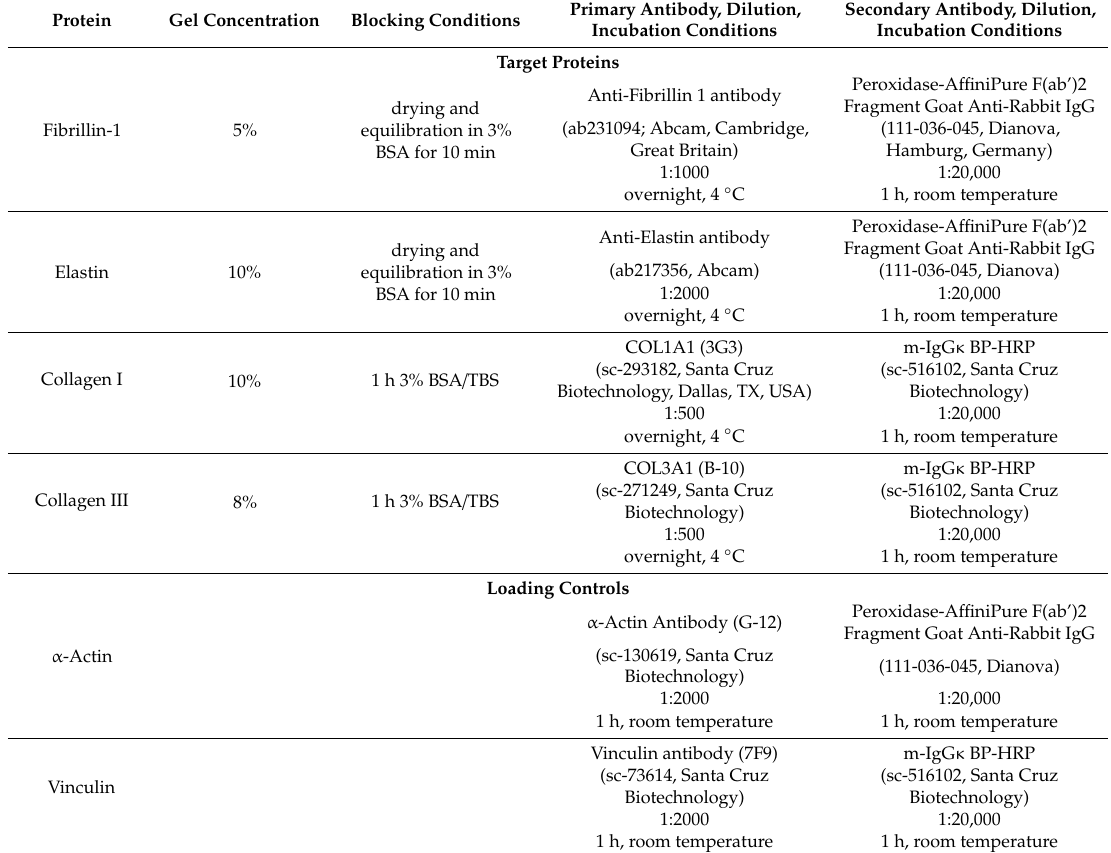
Table 1. Gel concentrations, blocking conditions, and antibodies used for Western Blot analysis.